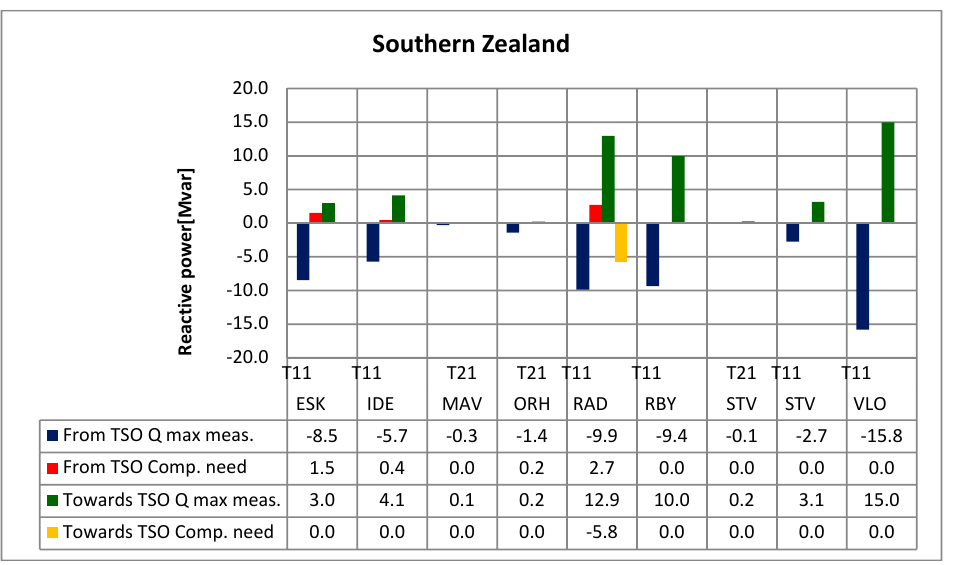
Figure 6. Bar ‐ chart showing highest measured flow of reactive power and the indicate requirement for compensation, in the southern Zealand.